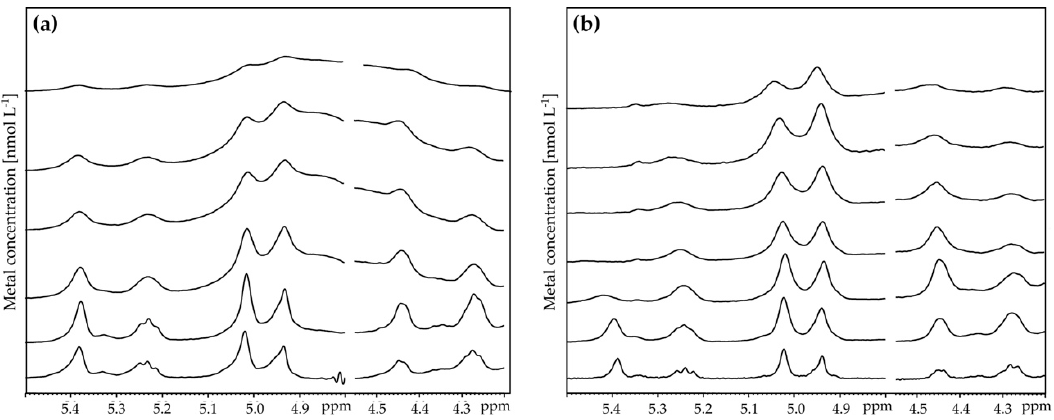
Figure 5. H NMR spectra of EPS-As3-5a(5) in D 2 O in presence of increased amounts of Ni 2+ (a) and Cu 2+ (b) , pH 5.1, T = 25 °C. Cu 2+ ( b ), pH 5.1, T = 25 ◦